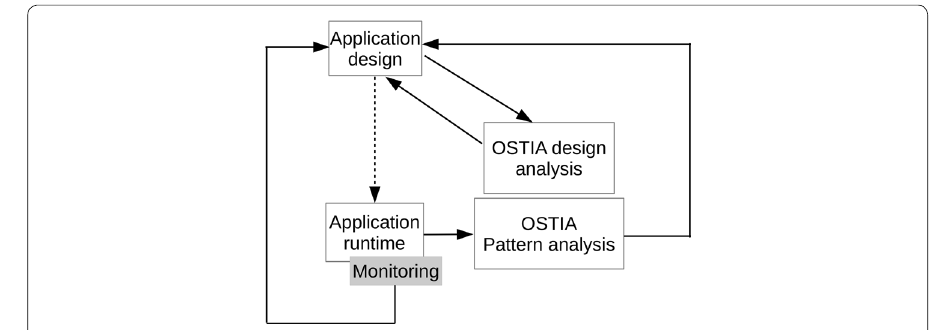
Fig. 2 Iterative refinement support by